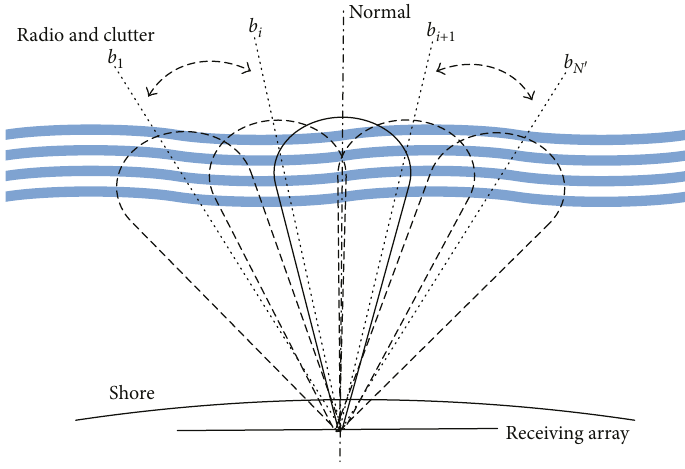
Figure 6: The spatial beam